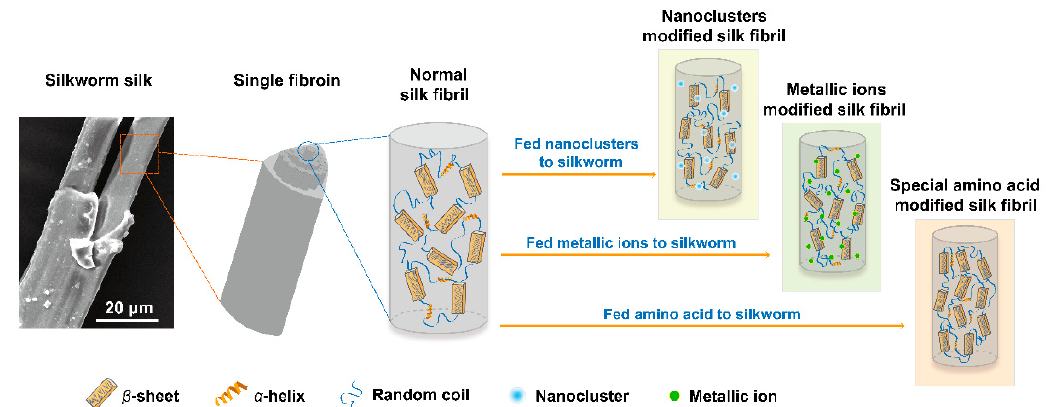
Figure 7. Schematic illustration of secondary structure of normal silk fibril and modified silk fibril in fibroin.